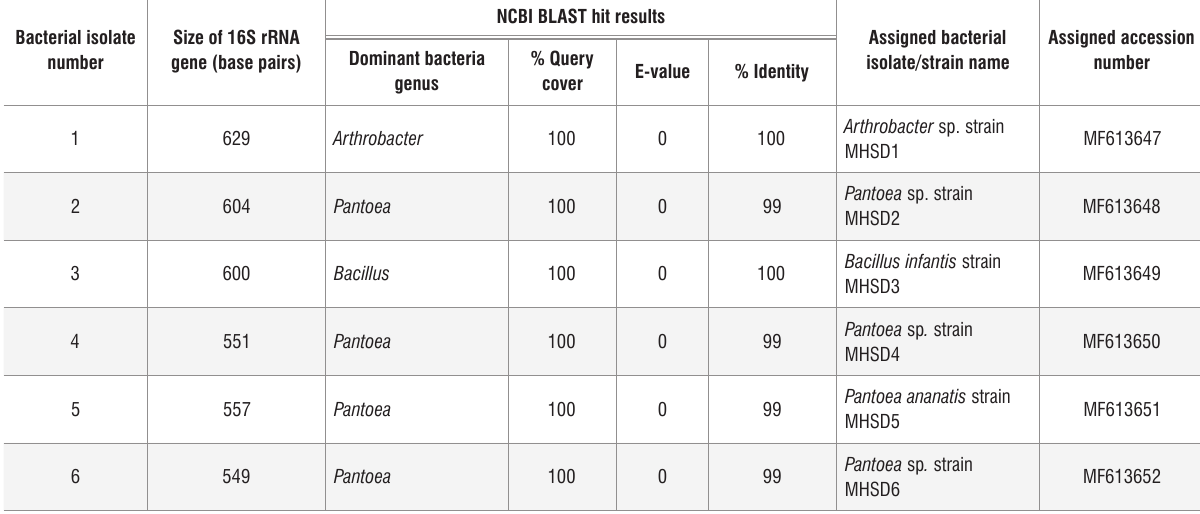
Bacterial isolate